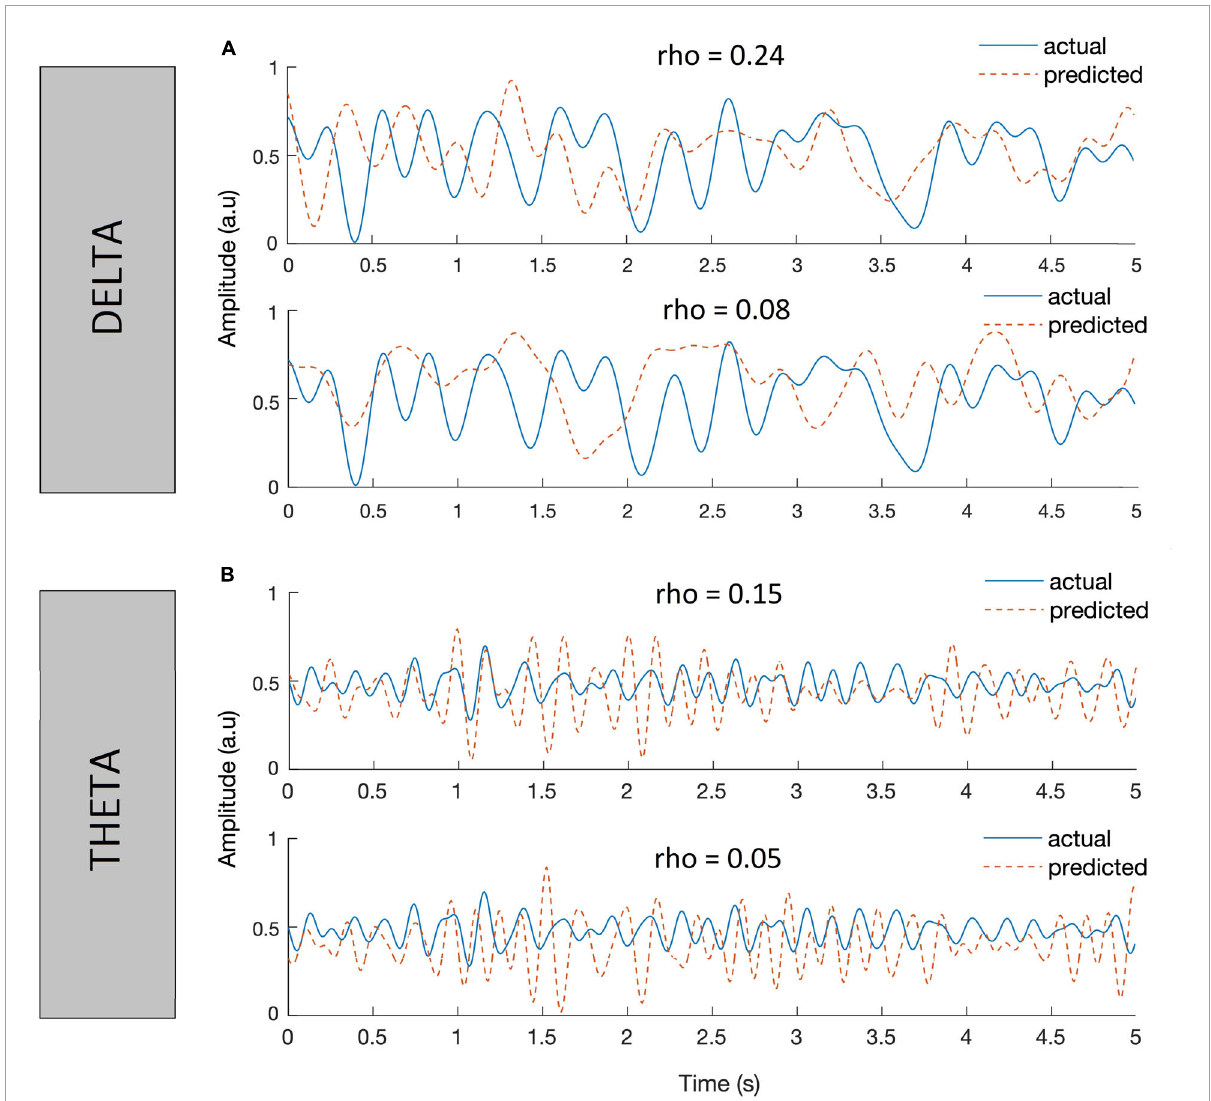
FIGURE9 Plots showing instances of actual speech envelopes (blue) and the reconstructed envelopes (red dotted) and bootstrapped Spearman correlation (rho) between them in delta (A) and theta (B)